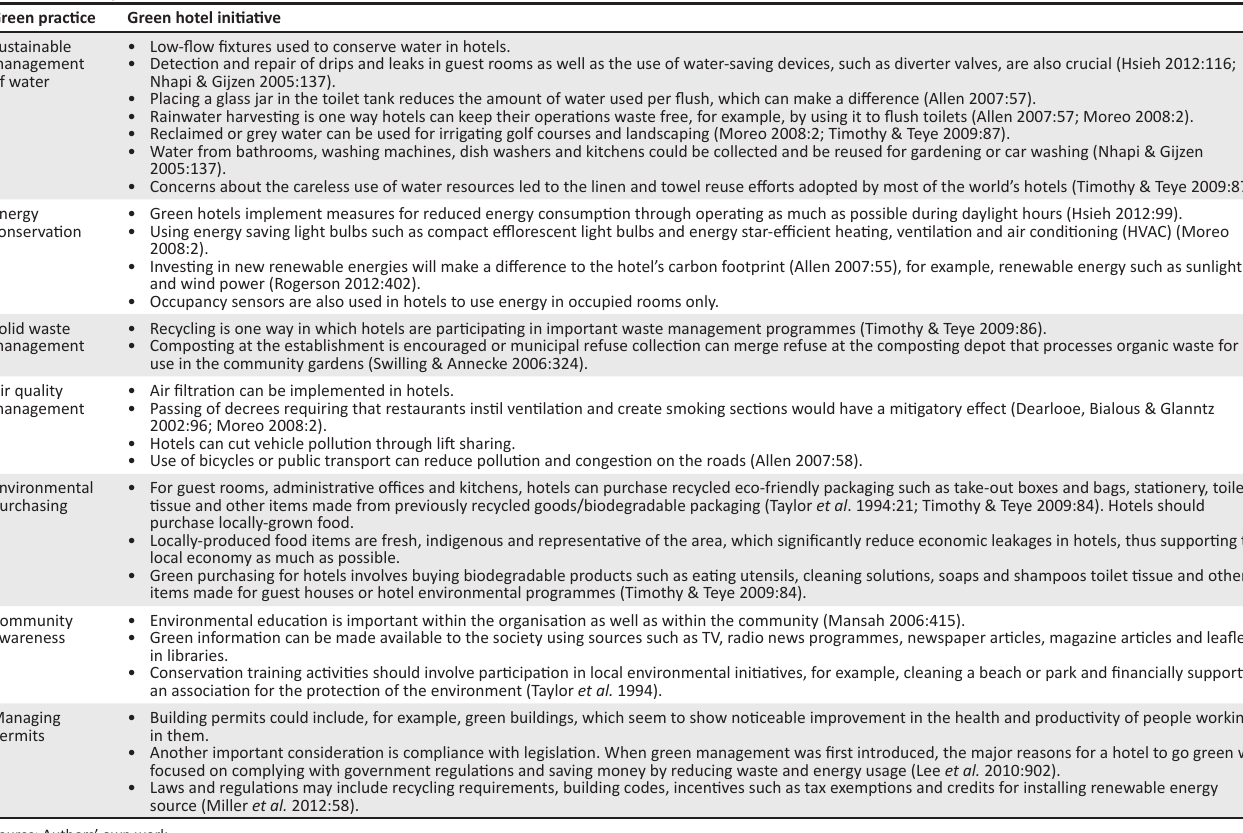
TABLE 1: Green practices in